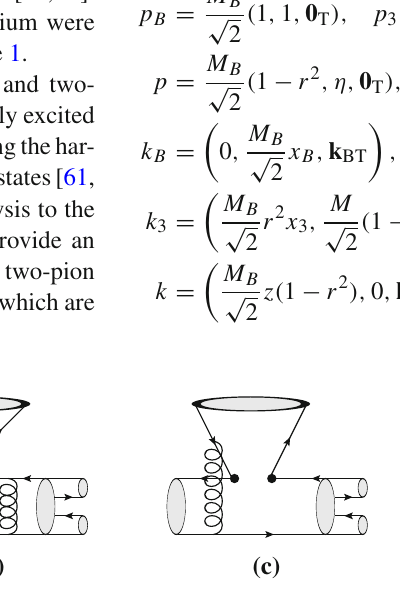
Fig. 1 The leading-order Feynman diagrams for the quasi-two-body decays B 0 s → ψ( 2 S , 3 S ) f 0 → ψ( 2 S , 3 S )π + π − , where f 0 stands for the S-wave intermediate